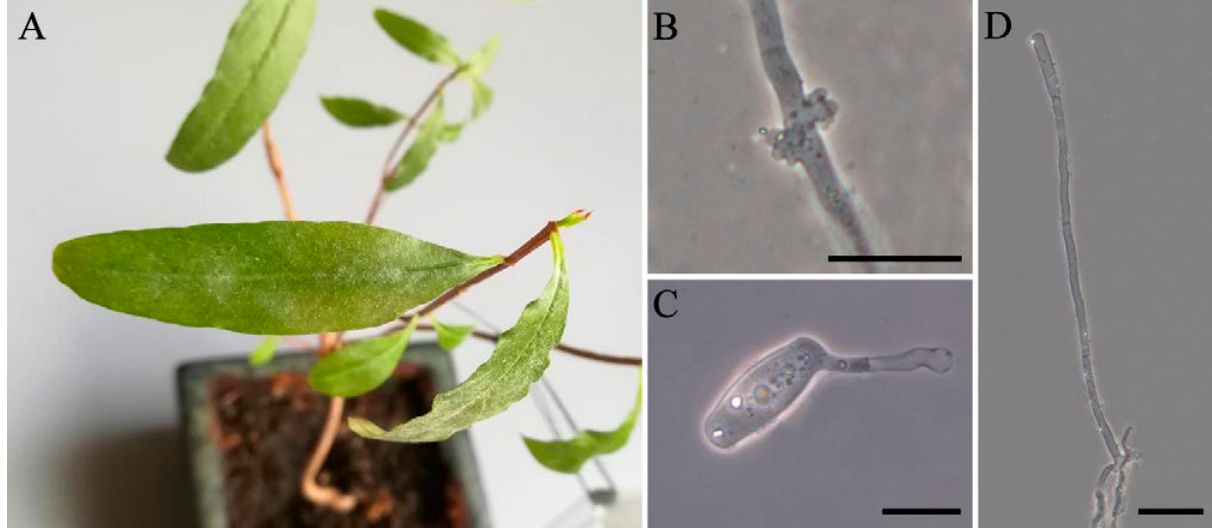
Figure 1. Erysiphe platani on Punica granatum . A: Symptoms of powdery mildew on Pu. granatum leaves. B: hyphal appressoria. C: germi- nating conidium. D: conidiophore. Bars = 50 μm.